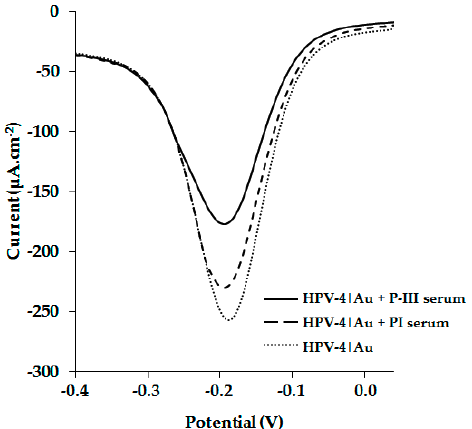
Figure 6. Polyclonal anti-HPV-4 detection using HPV-4|Au electrode by square-wave voltammetry (SWV). For unmodified electrode the minimal current density was − 575 µA.cm − 2 (at ~0.2 V). All measurements were performed in 1 mM Ru(NH 3 ) 6 Cl 3 in 0.50 M KCl at